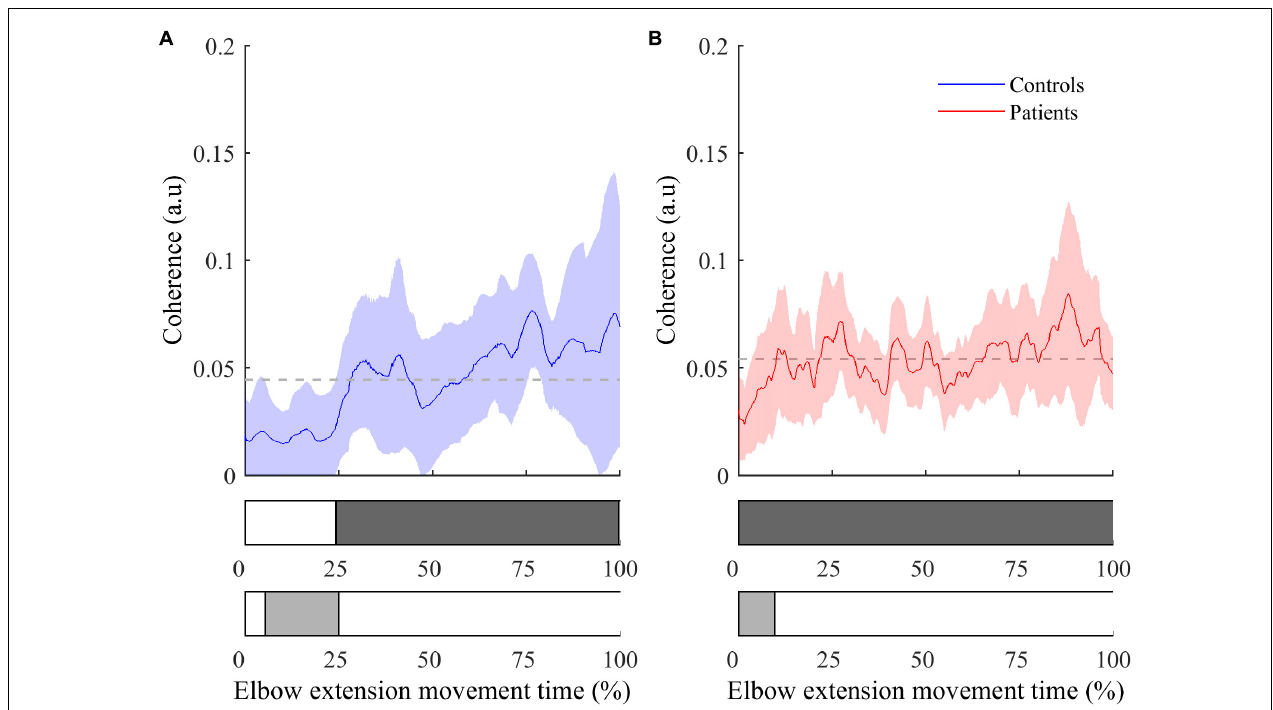
FIGURE 3 | Instantaneous CMC with BA muscle (mean ± 95% CI) as a function of time expressed in percent for controls (A) and patients (B) . The colored areas inside the horizontal bars beneath the graphs indicate time periods where CMC is significantly different from mean instantaneous CMC (light gray areas) or from null value (dark gray areas). In both graphs, the dashed lines represent the average CMC computed over the whole movement